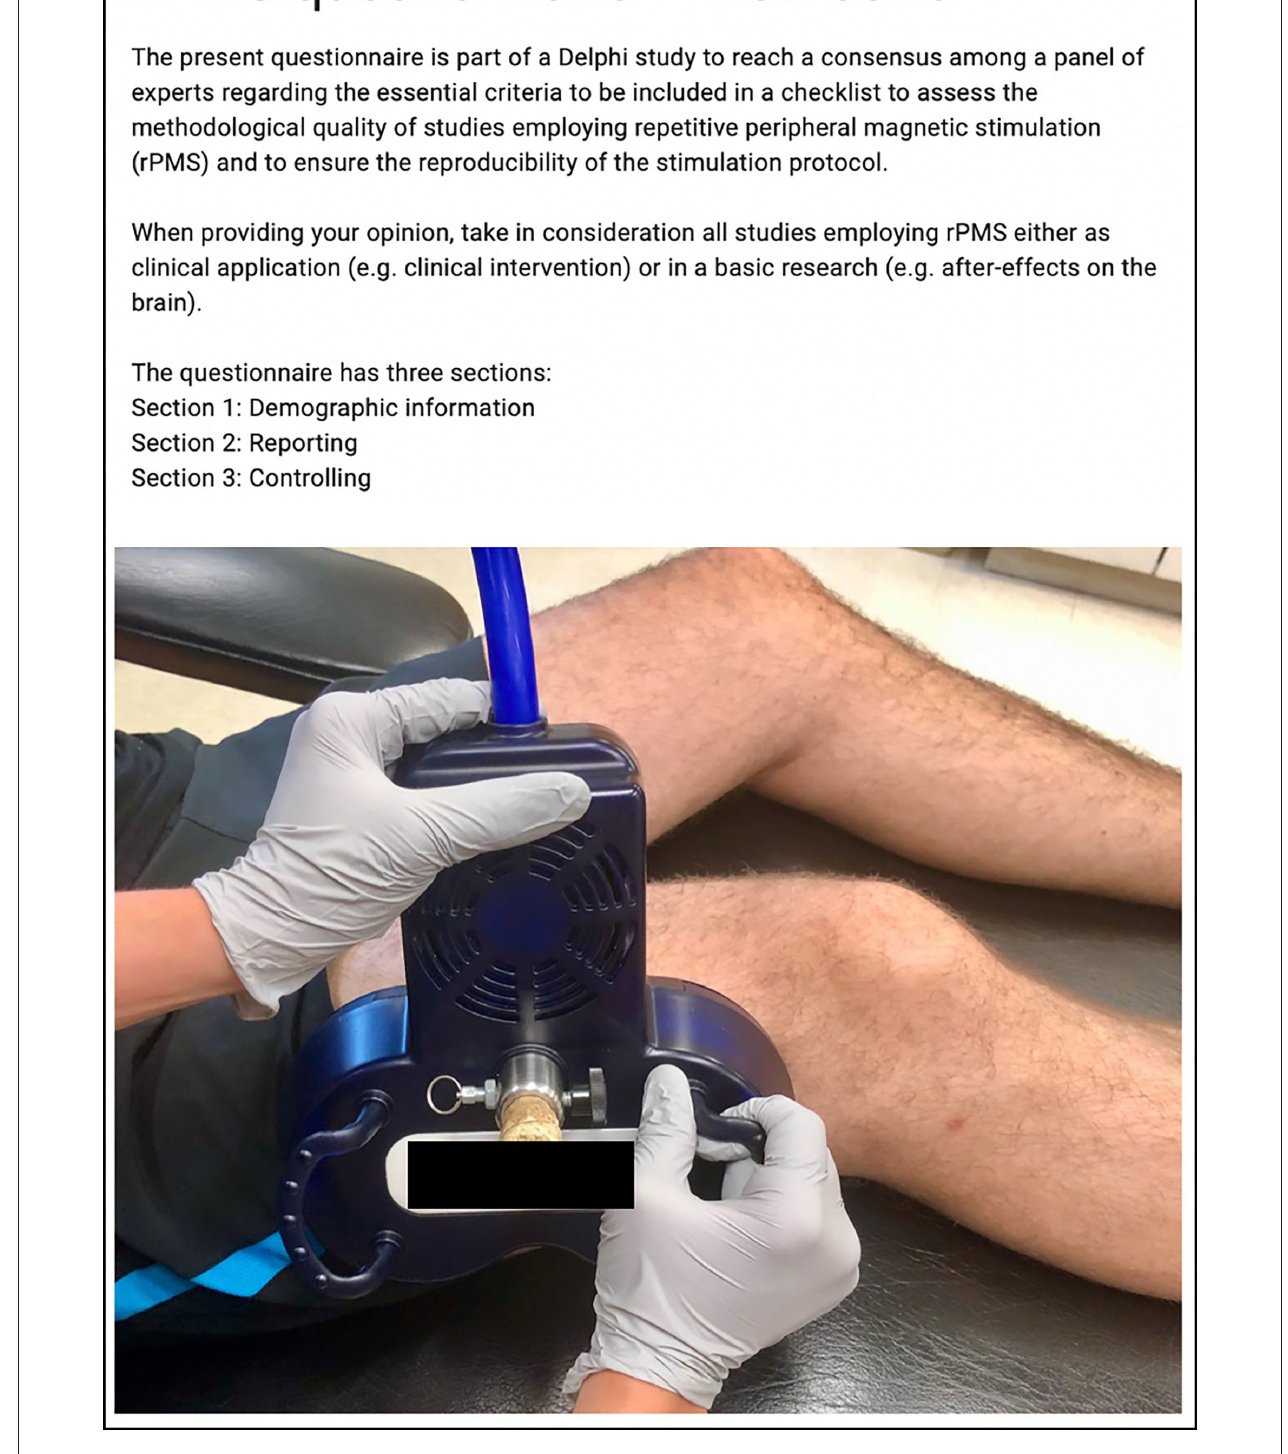
FIGURE 2 | Extract of the first page of the questionnaire for the guidelines to the experts and a custom picture of an example of rPMS administration.